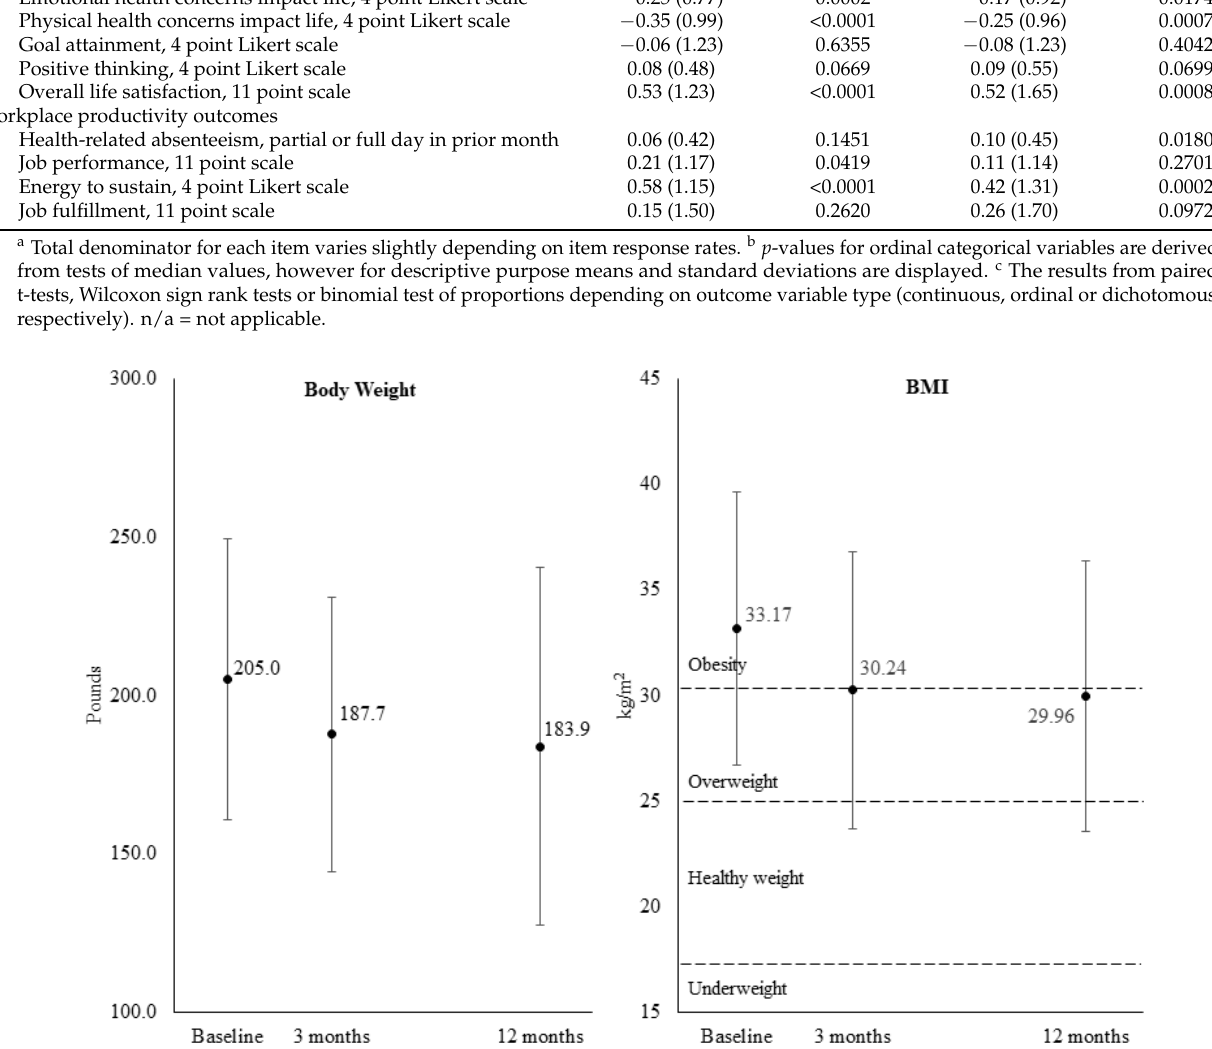
Figure 3. Average body weight and body mass index (BMI) of participants at baseline, 3 months and 12 months. Note: Graphs represent all available data at each time point and are not paired across